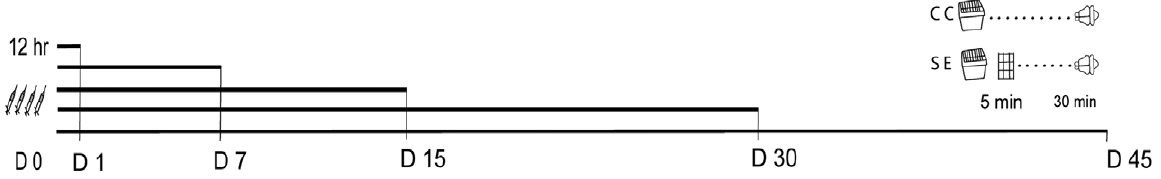
Figure 1. Schematic representation of the experimental procedure. BrdU was administered on day 0, in 4 separate ip injections (50 mg/Kg each) every 4 h from 9:00 A.M to 9:00 P.M. Animals were sacrificed 1, 7, 15, 30, or 45 days post BrdU injections (PBI), either from their home cages (cage control, CC) or 30 min after a 5-min spatial exploration (SE).